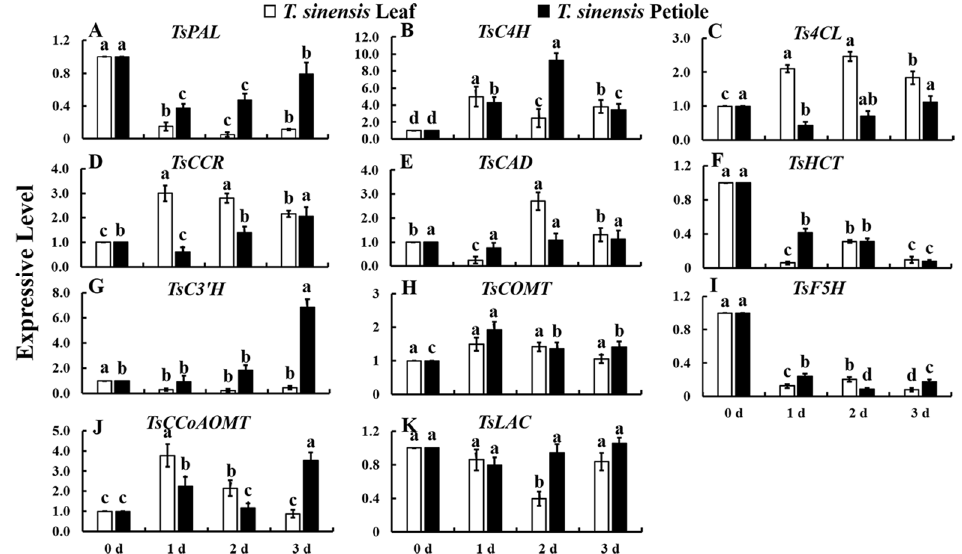
Figure 4. Relative expression level of lignin-related genes of red T. sinensis buds during storage. ( A ): The expression level of TsPAL in red T. sinensis during storage; ( B ): The expression level of TsC4H in red T. sinensis during storage; ( C ): The expression level of Ts4CL in red T. sinensis during storage; ( D ): The expression level of TsCCR in red T. sinensis during storage; ( E ): The expression level of TsCAD in red T. sinensis during storage; ( F ): The expression level of TsHCT in red T. sinensis during storage; ( G ): The expression level of TsC3’H in red T. sinensis during storage; ( H ): The expression level of TsCOMT in red T. sinensis during storage; ( I ): The expression level of TsF5H in red T. sinensis during storage; ( J ): The expression level of TsCCoAOMT in red T. sinensis during storage; ( K ): The expression level of TsLAC in red T. sinensis during storage. Different lowercase letters on the column indicates significant differences among different treatments ( p < 0.05).